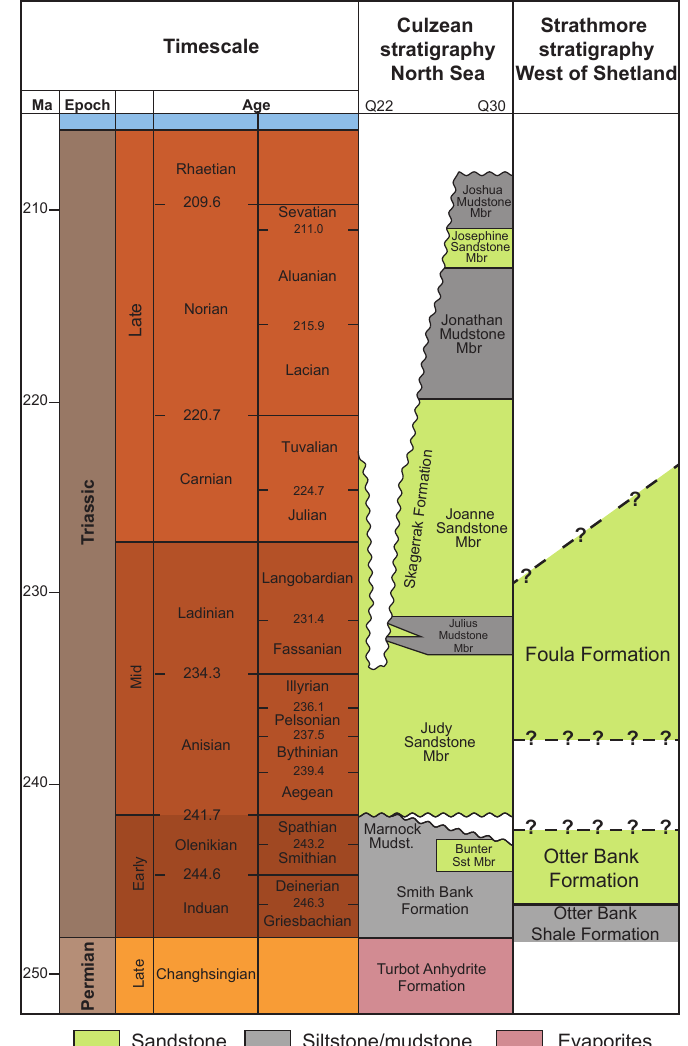
Figure 2. Triassic stratigraphy of the central North Sea and Strathmore Field areas, adapted